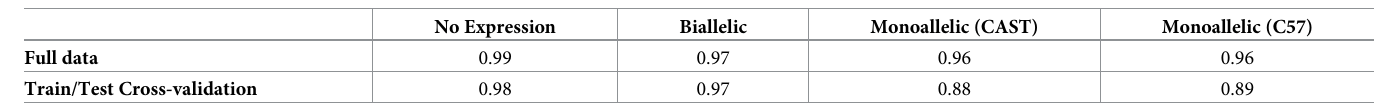
Table 1. Spearman correlation coefficients for predicted and actual fraction of cells in each category over genes.